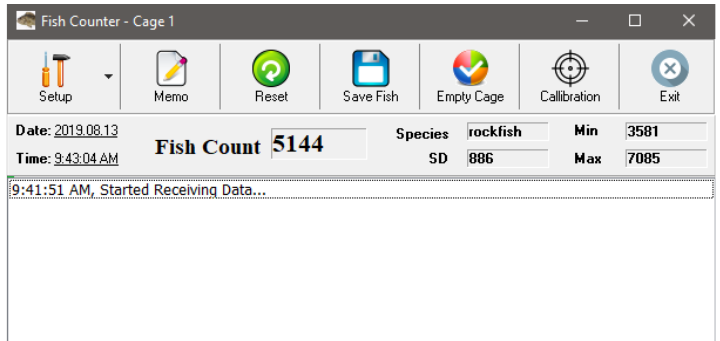
Figure 1. Screenshot of Fishcounter software displaying results from one of the experiments in